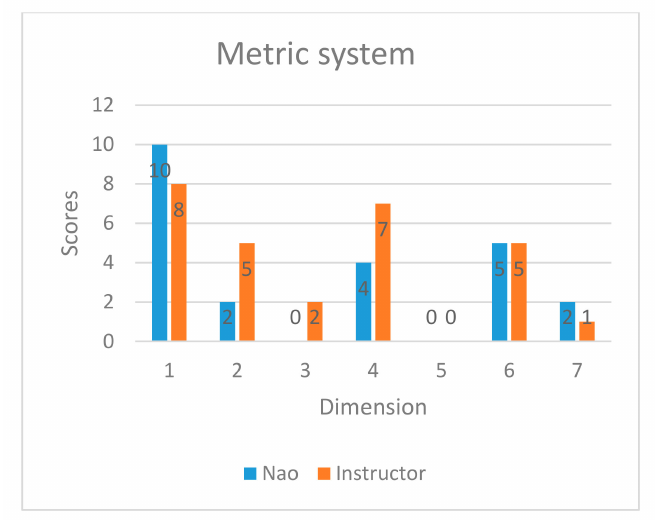
Figure 6. Results of the observation of the activity of the metric